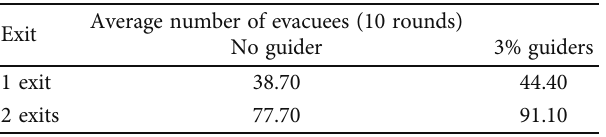
Table 2: Average number of evacuees of ten trial runs of 100 individuals with 0% and 3% guiders in simulations. Evacuation time period is set to 50s. The simulation domain is a room with one and two exits as Figure 3. The smoke source is located in the middle of the